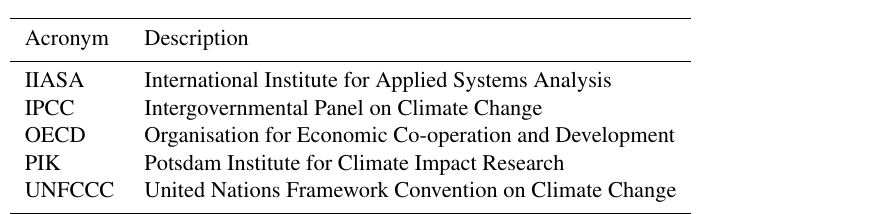
Table A6. Acronyms for institutions.